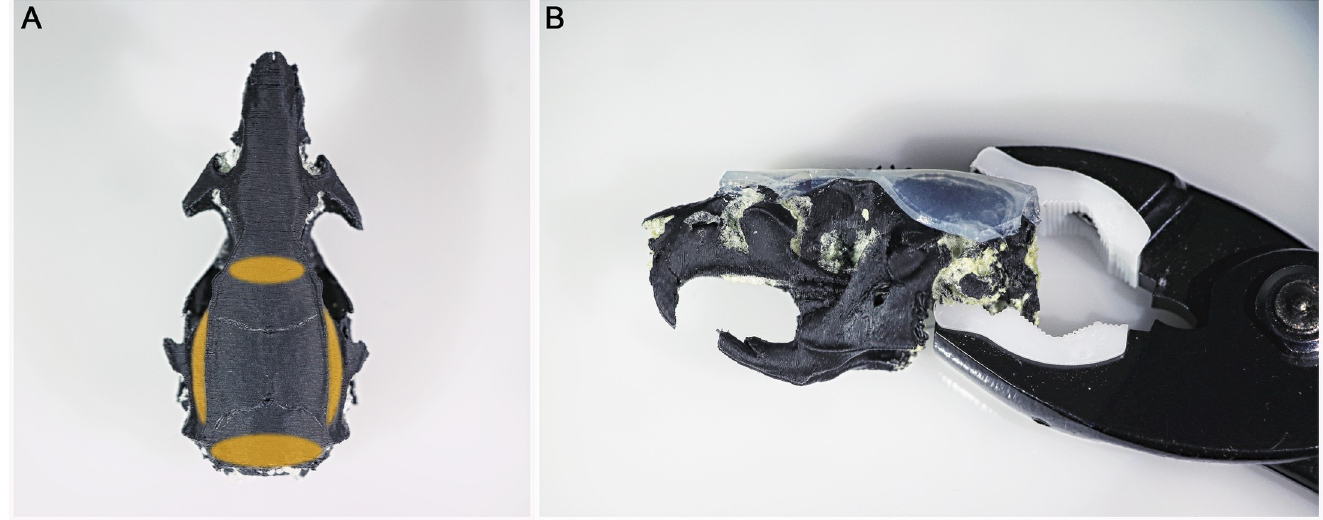
Fig 3. Skin addition process. (A) Zones where glue should be applied. (B) Clamping during the setting